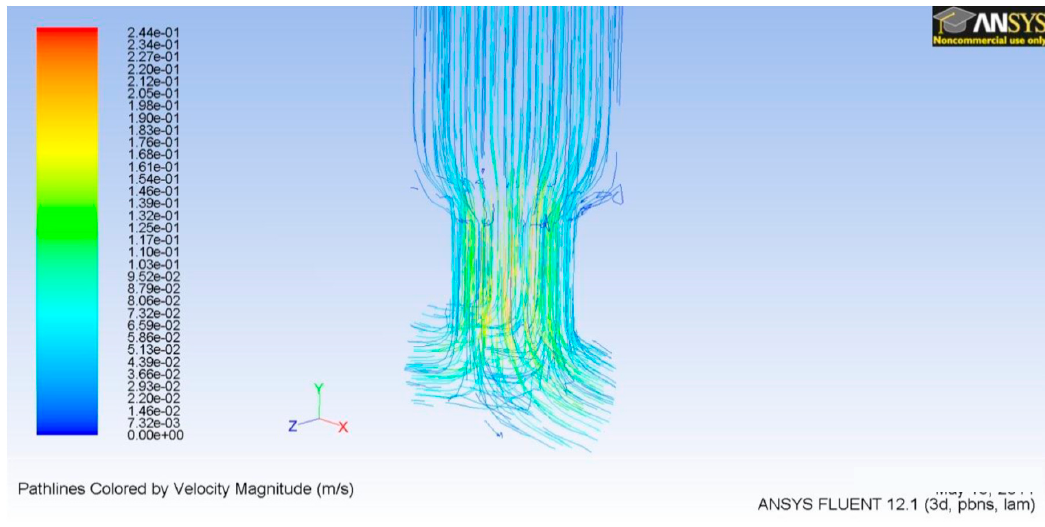
Figure 7. Velocity vectors for the microneedle outlet.